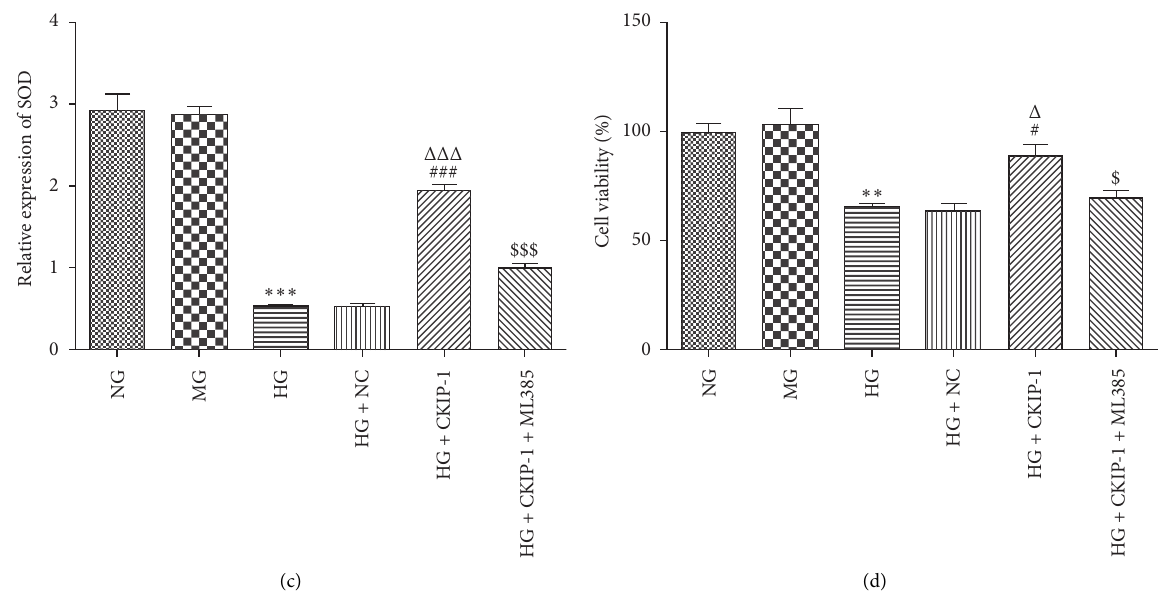
Figure 5: CKIP-1 suppresses oxidative stress and cell death induced by high glucose. (a) Relative production of ROS in different groups was evaluated by 2 ′ ,7 ′ -dichlorofluorescein (DCFH) levels. (b) Relative expression levels of malondialdehyde (MDA) were evaluated by assay kit. (c) Relative activity of superoxide dismutase (SOD) was assessed by assay kit. (d) Cell viability was determined by the CCK-8 assay kit. ∗∗∗ p < 0.001 vs. NG. ### p < 0.001 vs. HG. ΔΔΔ p < 0.001 vs. HG+NC. $ p < 0.05 and $$$ p < 0.001 vs. HG+CKIP-1. NG, normal glucose (5.5mM); MG,